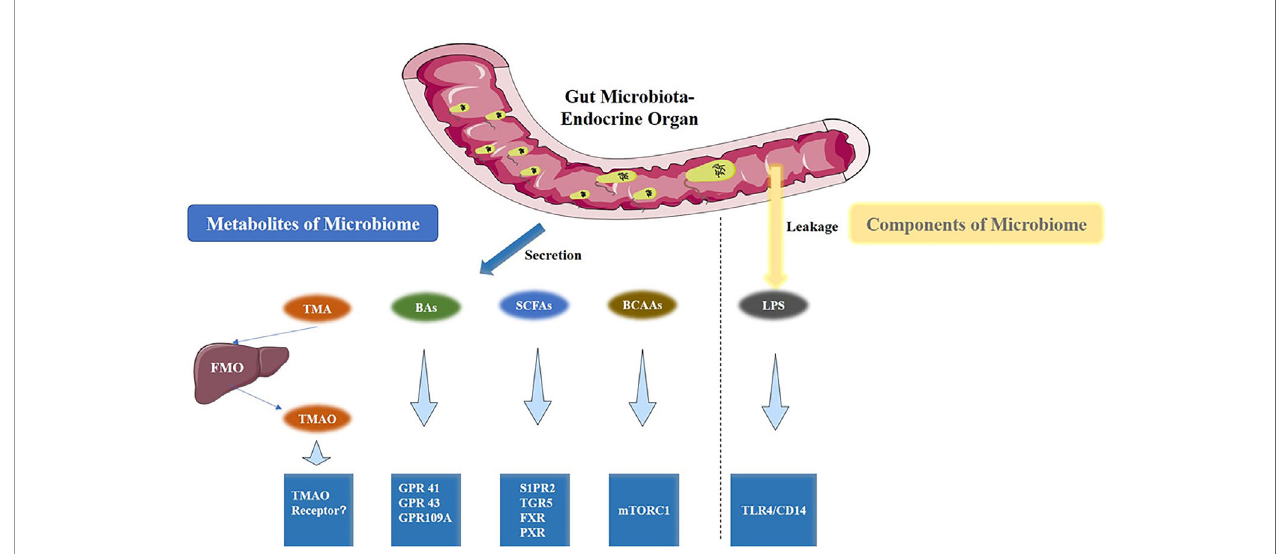
FIGURE 2 | Gut microbiota metabolites and the associated metabolic signaling pathway. TMAO, BAs, SCFAs, BCAAs are the metabolites that are produced by the gut microbiota. Conversely, LPS is a component of the cell wall of gut bacteria. All are capable of activating speci fi c signaling pathways. TMAO, Trimethylamine Oxide; BAs, bile acids; SCFAs, short-chain fatty acids; BCAAs, Branched-Chain Amino Acids; LPS,